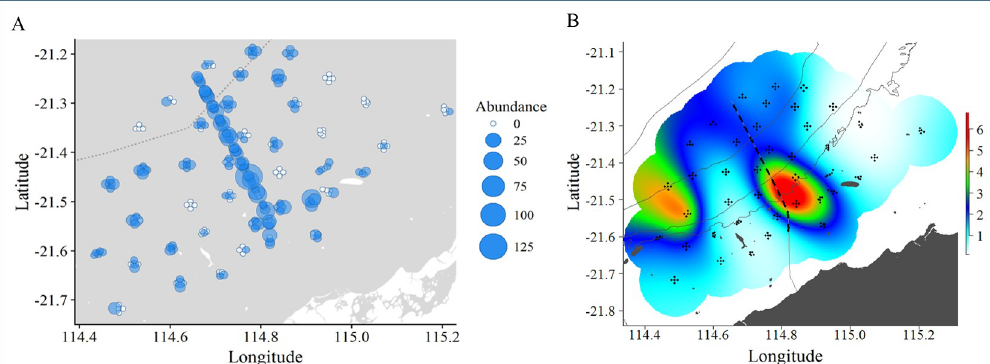
Fig 11. Relative abundance and spatial distribution of biomass of commercial fish species. a) Spatial distribution of the total relative abundance of commercial species (sum of MaxN’s for all commercial species). MaxN bubble sizes reflect abundance, and therefore bubble size may be larger or smaller than those in the legend. b) Smooth spline fits (GAMs) of the total biomass of all measured commercial species. Colour ramp is scaled to the biomass (kg) of all commercial species measured and is predicted by latitude and longitude